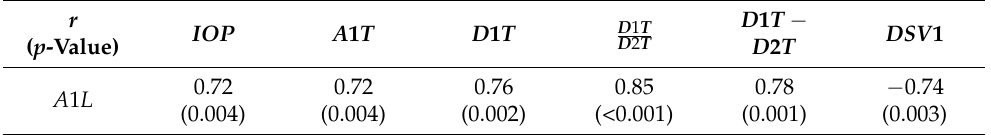
Table 4. Pearson’s correlation coefficients r higher than 0.7 between the first applanation length A 1 L and the selected parameters. The correlation p -values are placed in